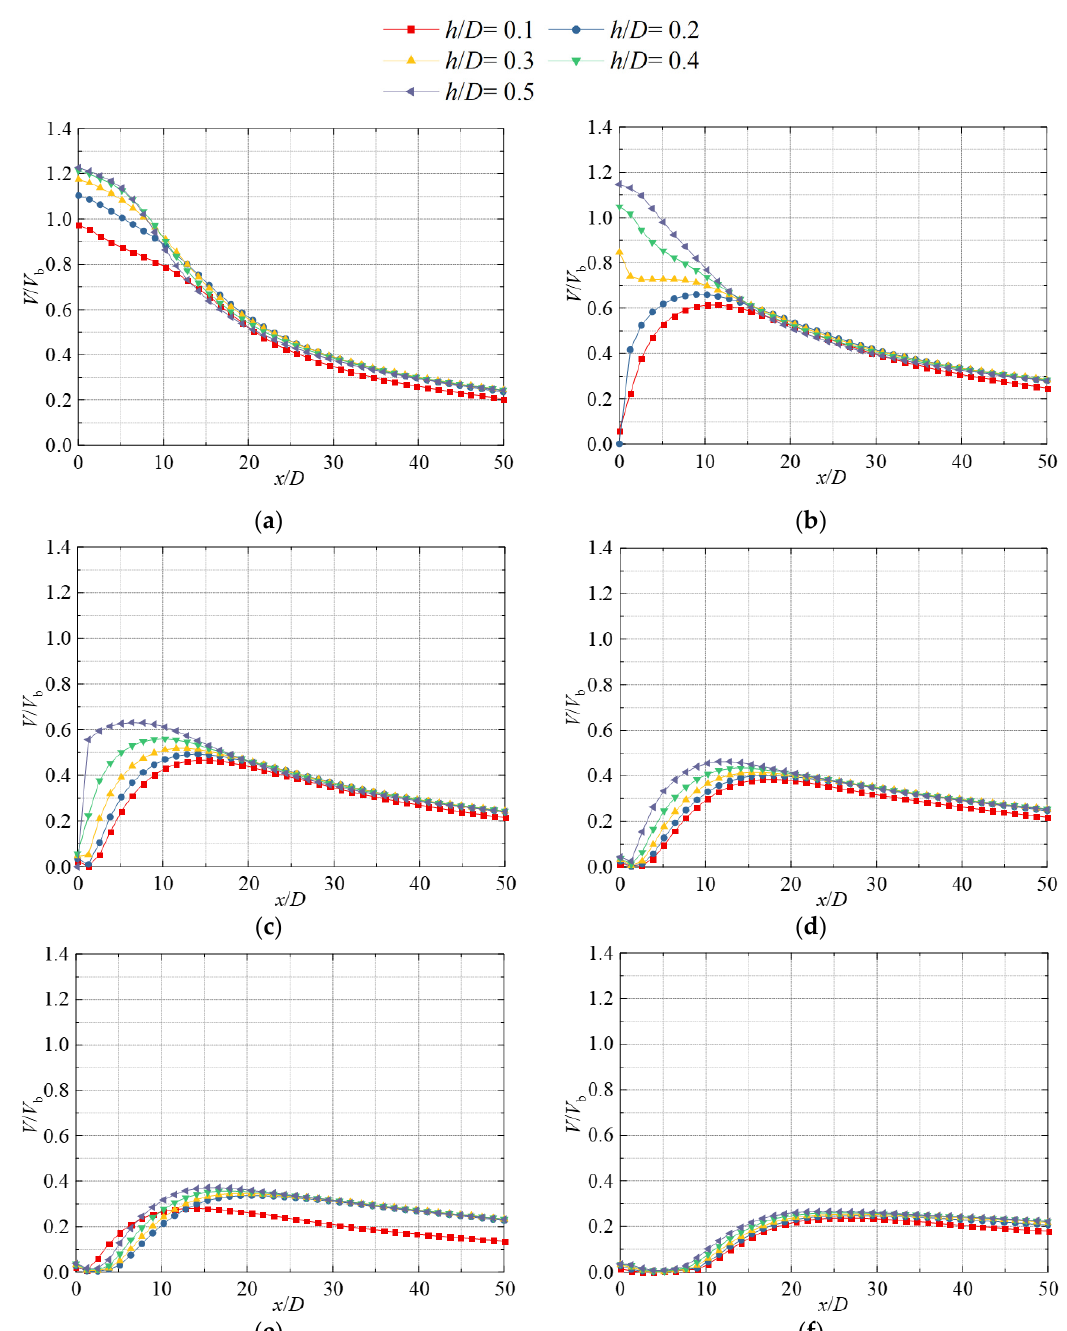
Figure 16. Distribution of near-wall dimensionless velocity V / V b at different incidence heights H / D : ( a ) H / D = 0.5; ( b ) H / D = 0.75; ( c ) H / D = 1; ( d ) H / D = 1.25; ( e ) H / D = 1.5; and ( f ) H / D = 2.